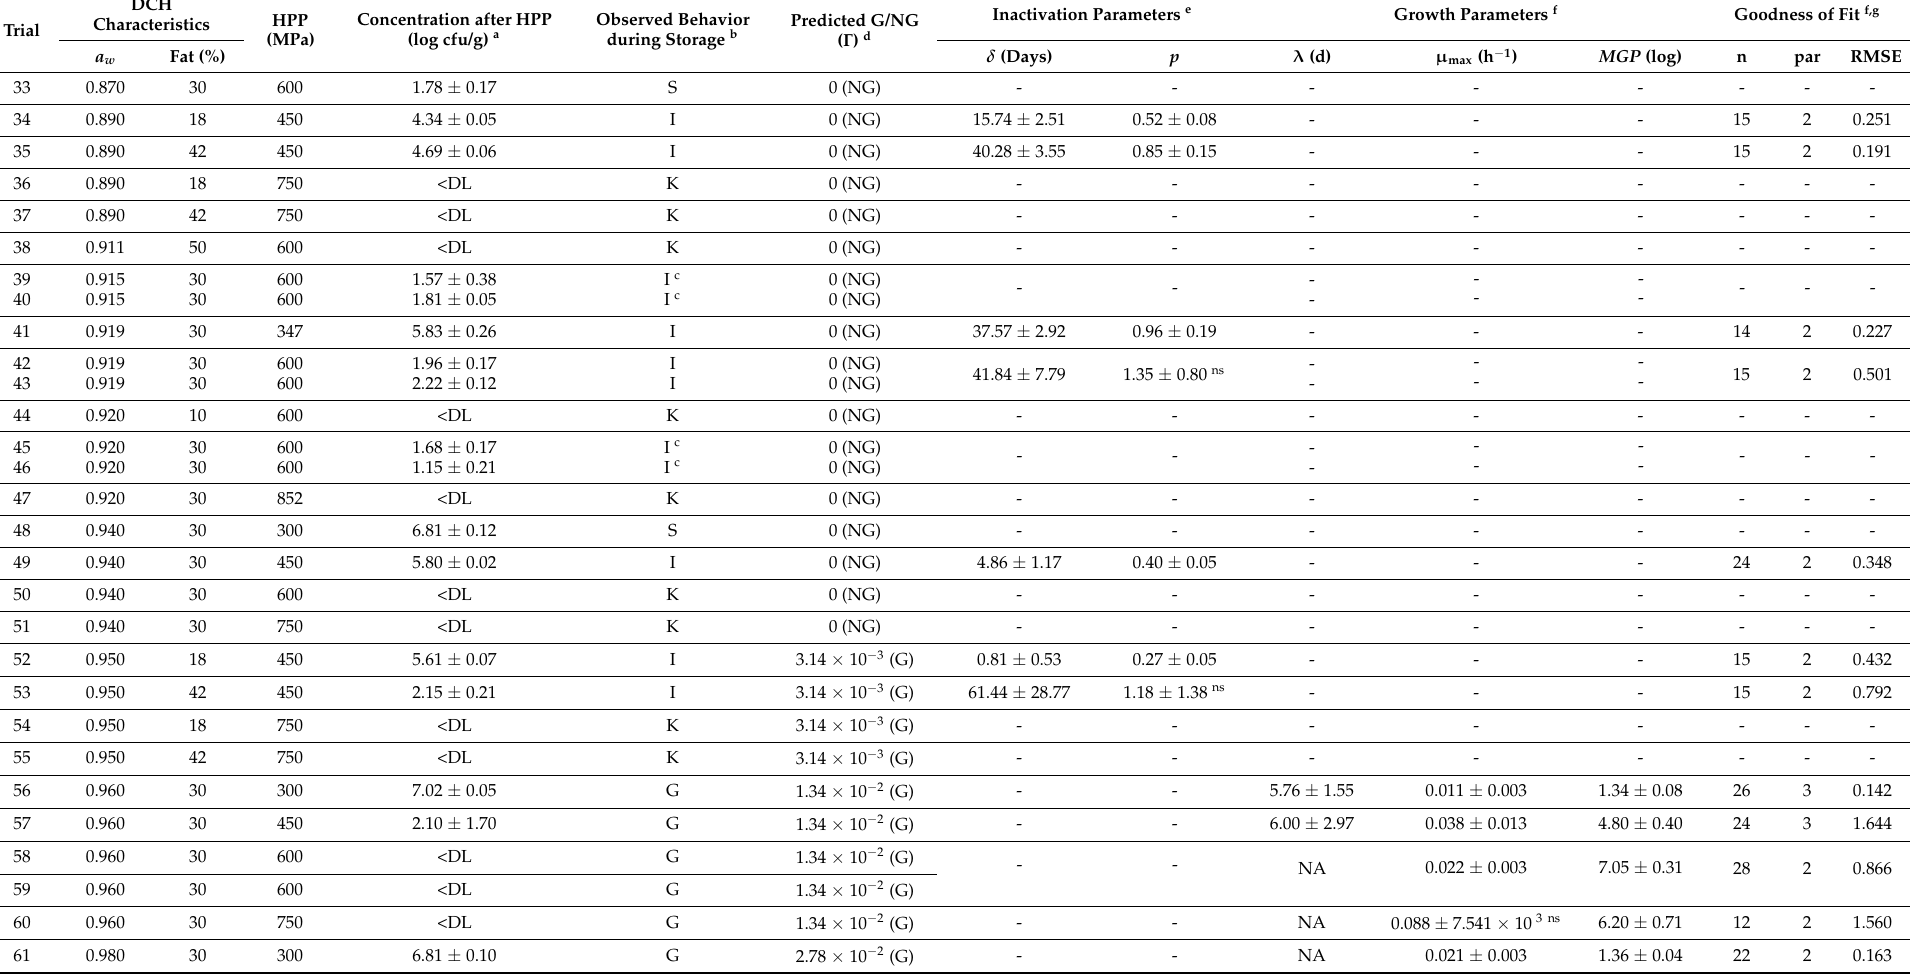
Table 2. L. monocytogenes concentration immediately after high pressure processing (HPP) in the different trials and estimated parameter values resulting from fitting the primary models to the L. monocytogenes inactivation/growth counts observed during the storage of pressurized dry-cured ham (DCH) at 7 ◦